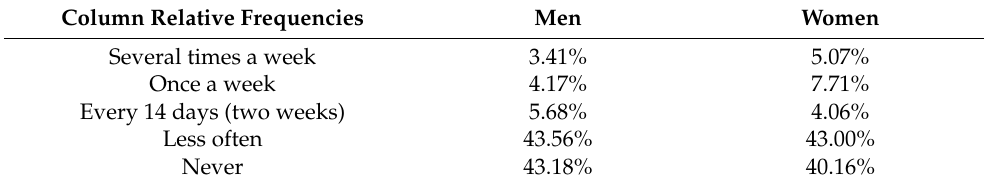
Table 8. Contingency table, Markets and farmers’ markets & Respondent’s